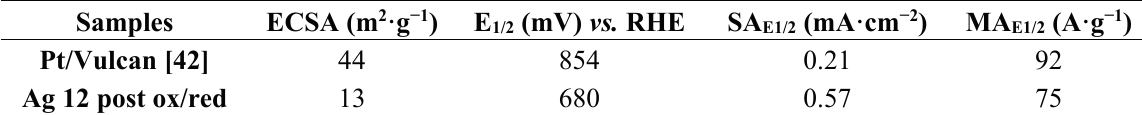
Table 2. Kinetic parameters of a commercial Pt/Vulcan catalyst and the Ag 12 post ox/red sample: electrochemical surface area (ECSA) half wave potential (E 1/2 ), specific activity (SA E1/2 ) and mass activity (MA E1/2